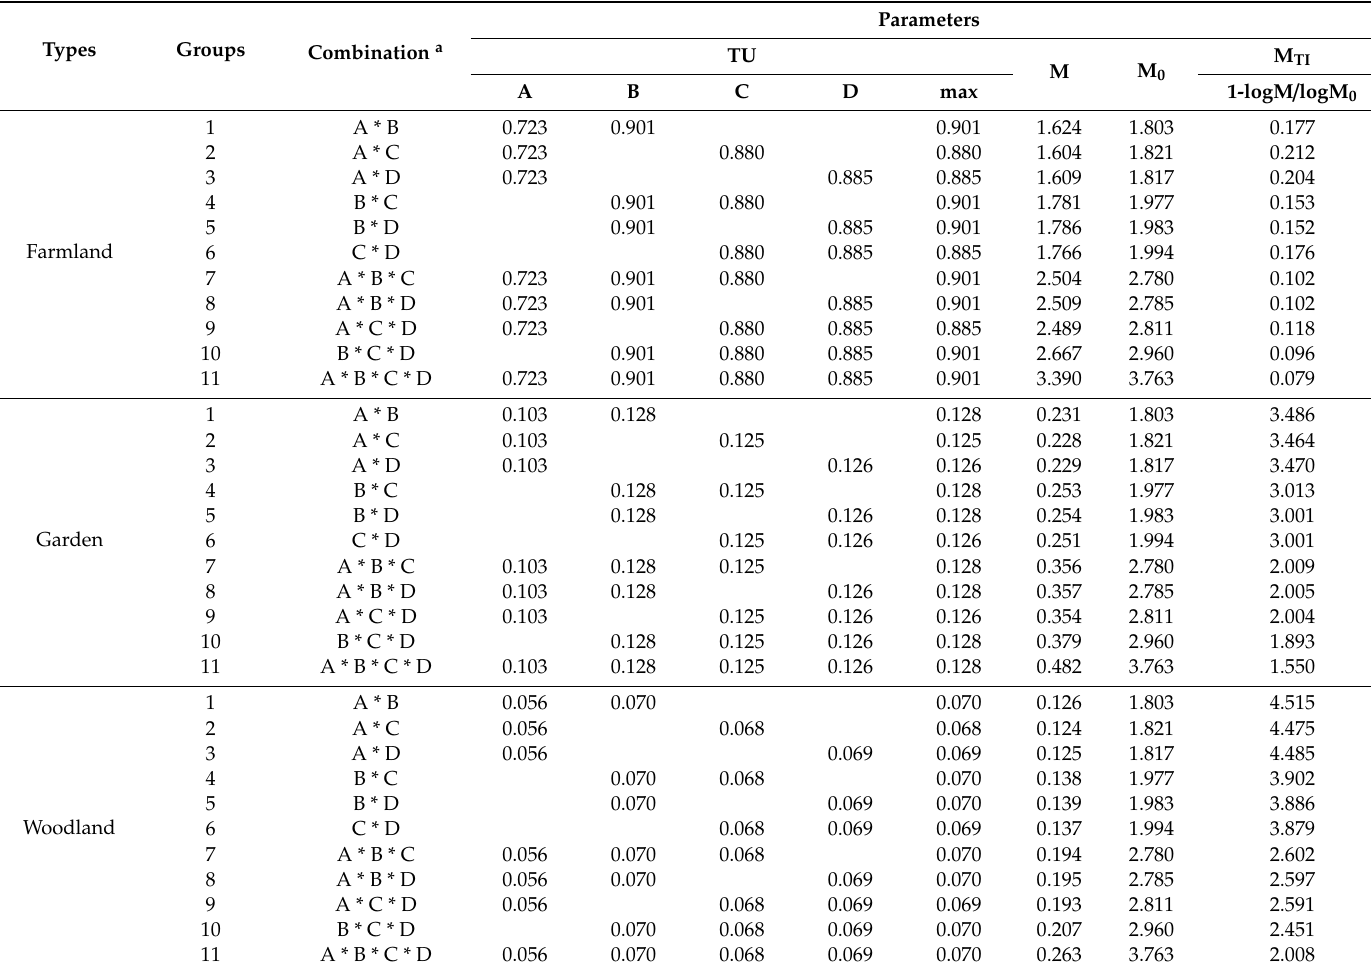
Table 8. Combined toxicity of QNs on ryegrass before and after modification in three soil